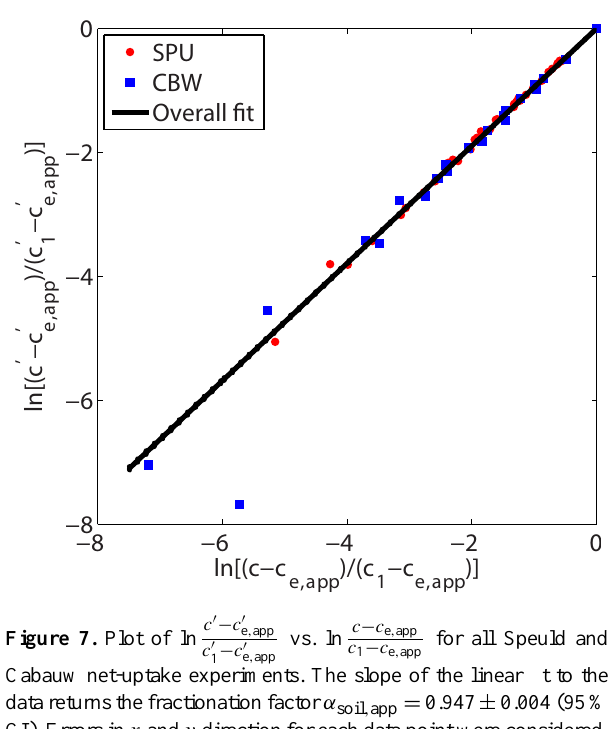
c (cid:48) − c (cid:48) e , app c − c e , app for nine vs. c e , app ln c 1 − c e , app − c (cid:48) c (cid:48) e , app 1